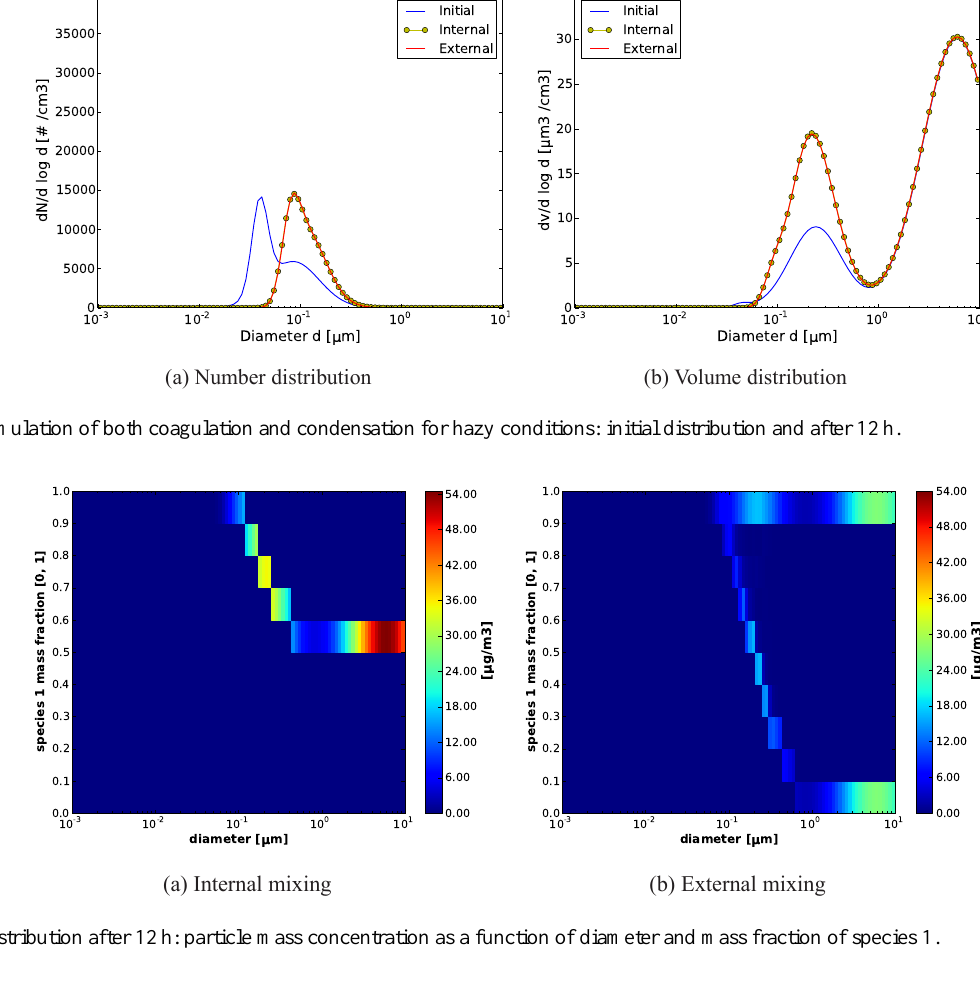
BiNGA, NIT3, BiNIT, AnCLP, SOAlP, SOAmP, SOAhP, POAlP, POAmP and POAhP); the black carbon group (BC) contains only black carbon; and the dust group (DU) contains all the neutral particles made up of soil, dust and fine